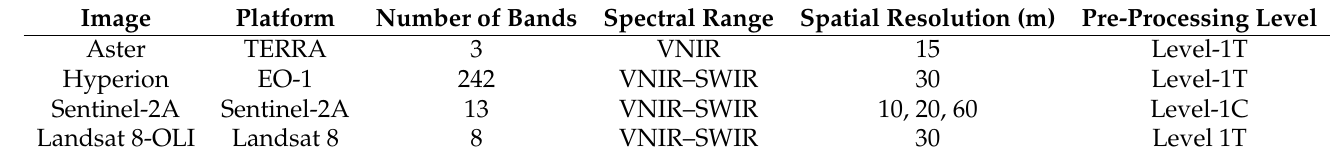
Table 1. Satellite image